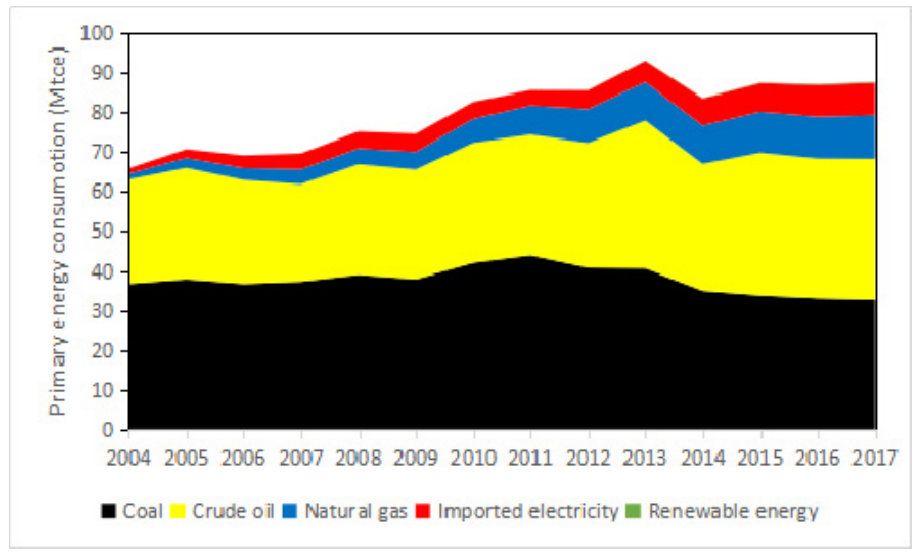
Figure 2. The primary energy consumption in Shanghai during the period from 2004 to 2017. Date source: Shanghai Statistical Yearbook [25]; Shanghai Statistical Yearbook on Energy 2015 [27].